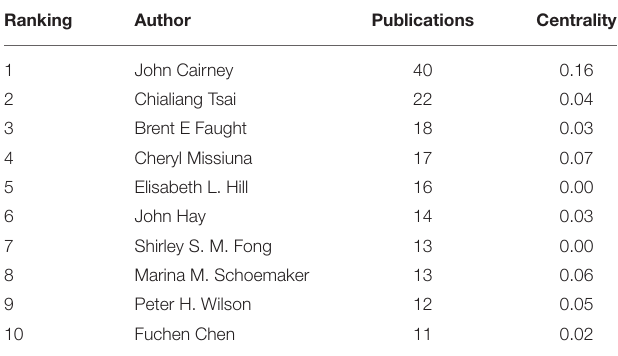
TABLE 3 | Top 10 active authors in research of children with DCD,